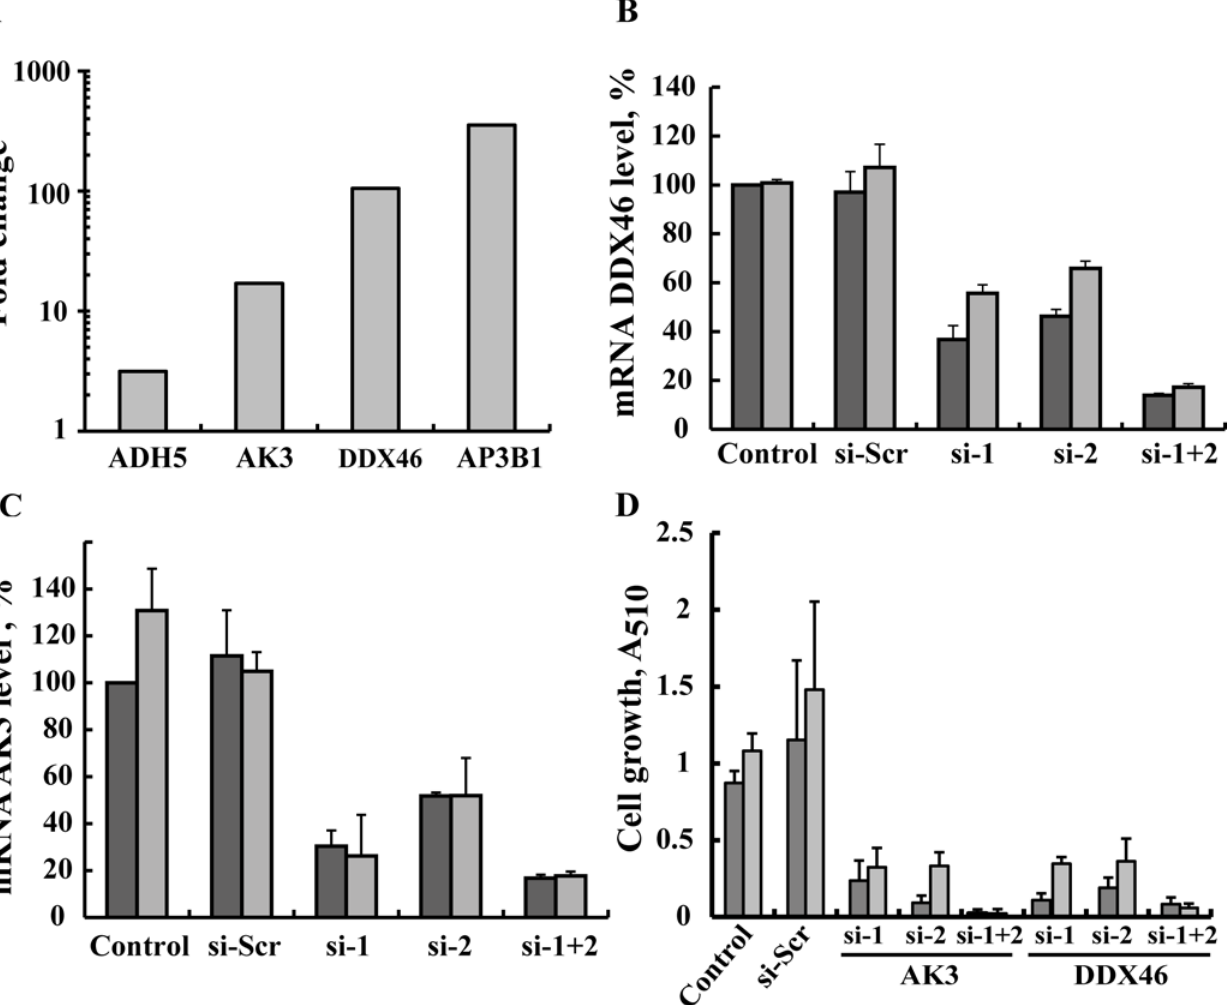
Fig 2. siRNA silencing of AK3 or DDX46 expression inhibits cell growth. ( A ) Differential expression of the 4 proteins not previously connected to any cancer between healthy and CLL individuals. ( B-D ) MEC-1 cells were transfected with (50 nM) scrambled siRNA (si-Scr,), one of the 2 different siRNAs against AK3 (siAK3 1 or 2), or against DDX46 (si-DDX46 1 or 2), a combination of siAK3 1 and 2 or a combination of siDDX46 1 and 2 and, at the indicated time, were analyzed for AK3 and DDX46 mRNA levels by RT-PCR ( B,C ) or analyzed for cell growth using the SRB method (n = 3) ( D